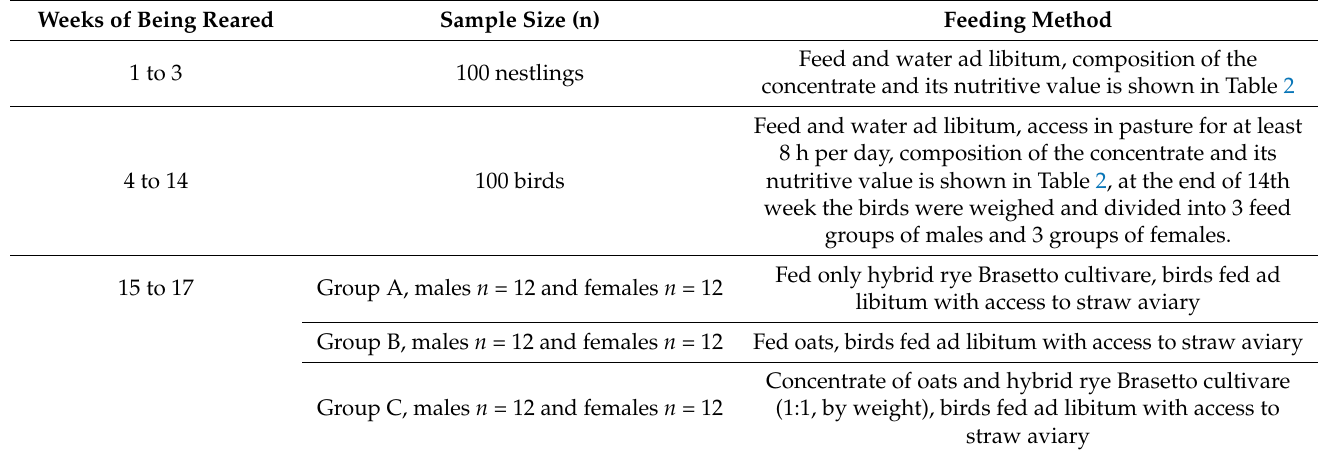
Table 1. The experimental plan of the Zatorska geese breed fed different kinds of cereals. Weeks of Being Reared Sample Size (n) Feeding Method